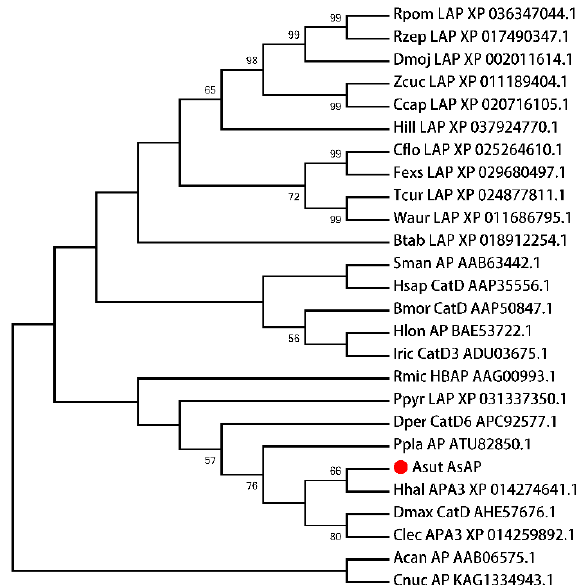
Figure 2. The phylogenetic relationships in the Adelphocoris suturalis aspartic protease ( AsAP ). A neighbor-joining tree was constructed using the JTT model for amino acids with confidence values (>50%) shown on the branches, which were based on 1000 rapid bootstrap replicates. Species ab- breviations are: Asut , Adelphocoris suturalis; Hlon, Haemaphysalis longicornis ; Ppla, Pristhesancus pla- gipennis ; Cflo, Camponotus floridanus ; Hill, Hermetia illucens ; Dper, Dysdercus peruvianus ; Dmoj, Dro- sophila mojavensis ; Zcuc, Zeugodacus cucurbitae ; Ppyr, Photinus pyralis ; Btab, Bemisia tabaci ; Fexs, For- mica exsecta ; Rpom, Rhagoletis pomonella ; Rzep, Rhagoletis zephyria ; Ccap, Ceratitis capitate ; Tcur, Tem- nothorax curvispinosus ; Waur, Wasmannia auropunctata ; Dmax, Dipetalogaster maximus ; Rmic, Rhip- icephalus microplus ; IRic, Ixodes Ricinus ; Bmor, Bombyx mori ; Sman, Schistosoma mansoni ; Acan, Ancy- lostoma caninum ; Hsap, Homo sapiens ; Cnuc, Cocos nucifera ; Hhal, Halyomorpha halys ; and Clec, Cimex lectularius.